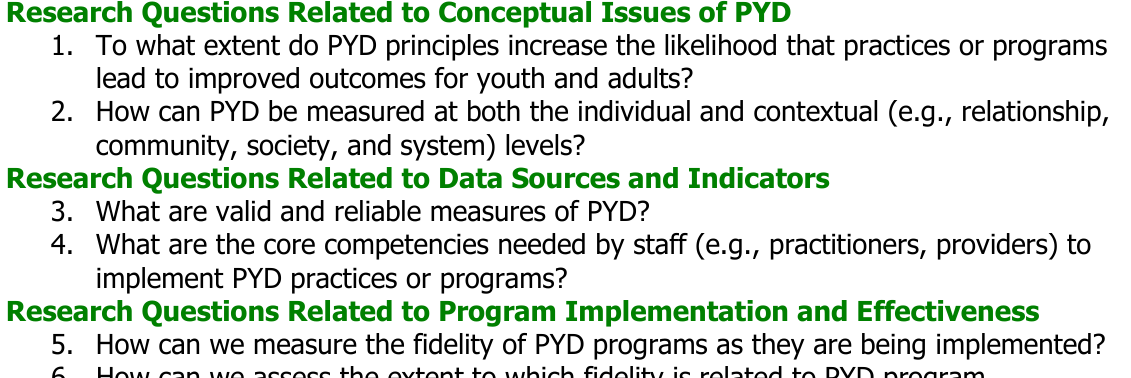
Figure 1. Questions Included in the Federal Research